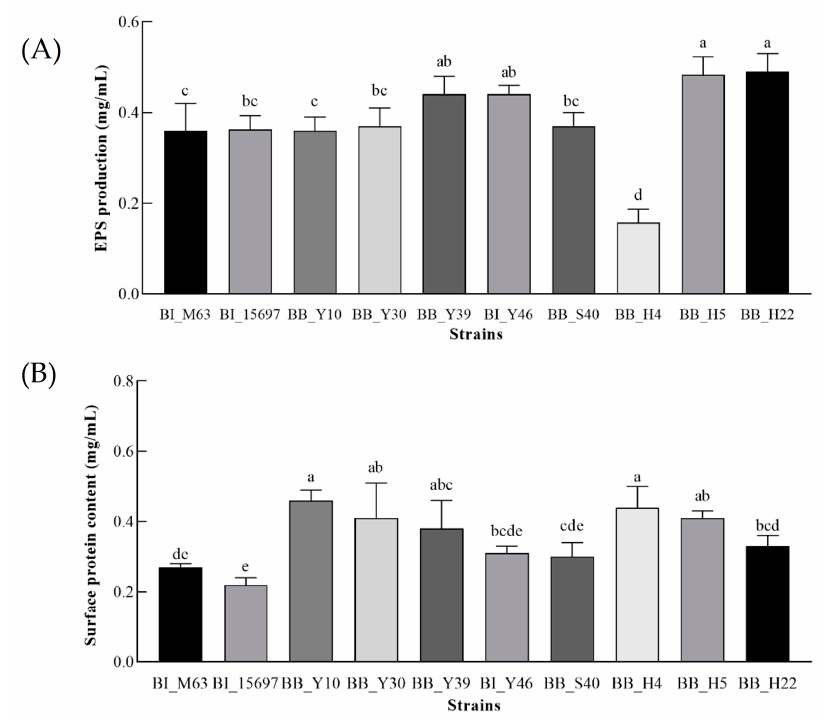
Figure 3. The Exopolysaccharide (EPS) production ( A ) and surface protein contents ( B ) of the screened bifidobacteria. Different lowercase letters represent significant differences among different strains. Table 1. The auto-aggregation ability of screened